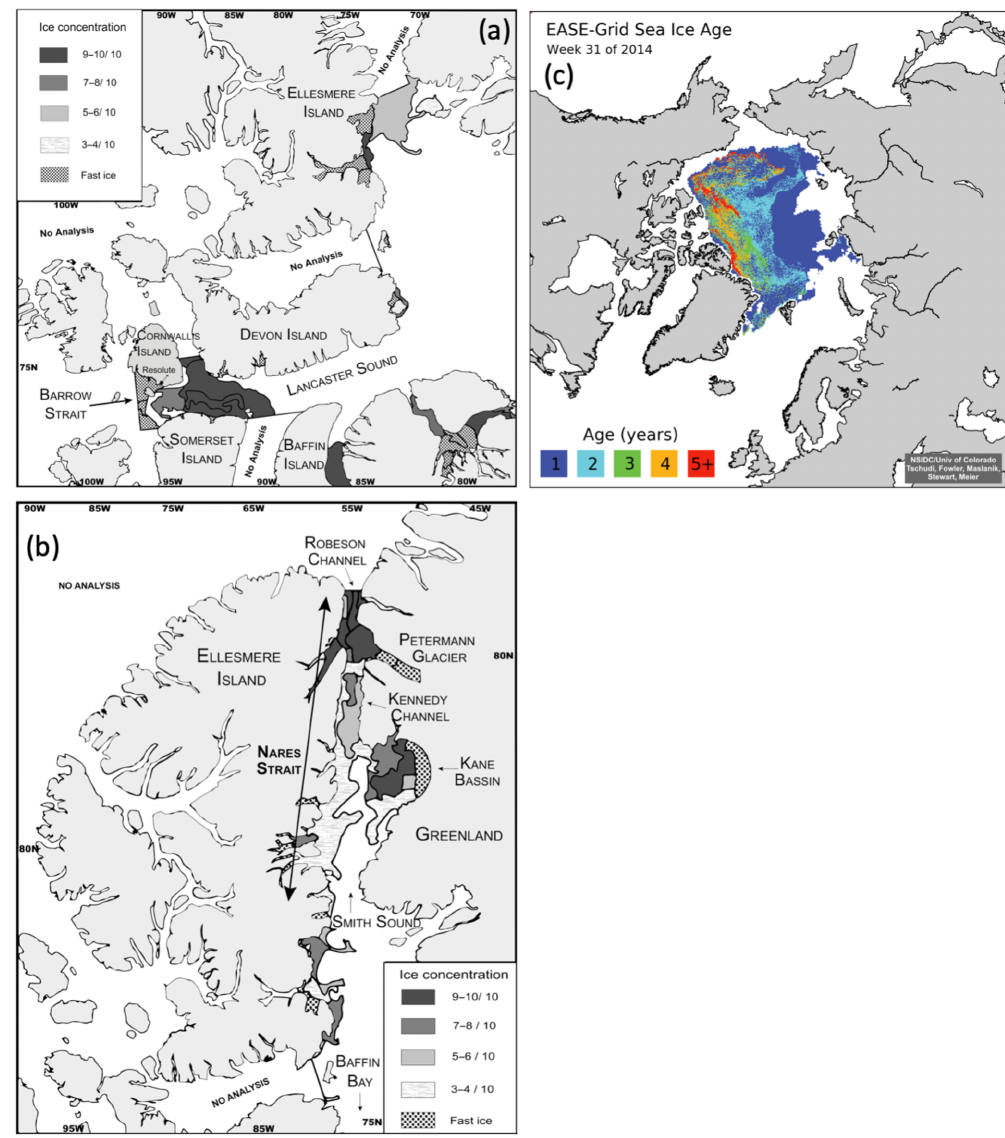
Figure 2. Ice charts adapted from the Canadian Ice Services (CIS) of Environment Canada showing the presence of ice edges in (a) Lancaster Sound with 9–10 / 10 ice concentrations ( > 15cm) extending from Devon Island into the Prince Regent Inlet between Somerset and Baffin islands (22 July 2014); and in (b) Nares Strait with 9–10 / 10 ice concentrations near Petermann Glacier (1 August 2014); (c) shows the presence of MYI (2 to 5 + years) at the entrance of Robeson Channel as well as a band of FYI (1) (EASE-Grid Sea Ice Age, Version 3 data set; Tschudi et al., 2016). See the Canadian Ice Services Archives website for more details about sea ice characteristics. Note that Nares Strait includes Smith Sound, Kane Basin, Kennedy Channel, Hall Basin, and Robeson